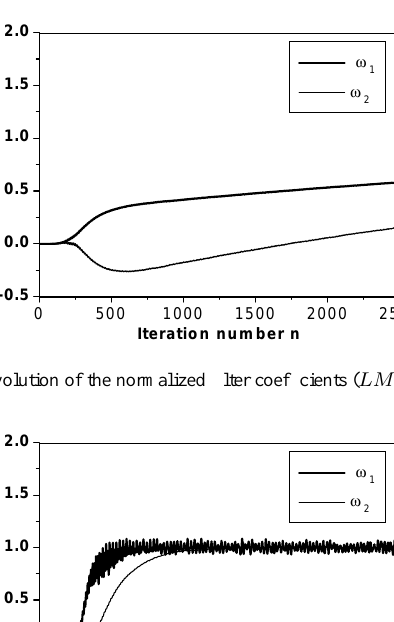
Fig. 20. Evolution of the normalized filter coefficients ( SM − BNDRLMS ), case ( C 4 ).